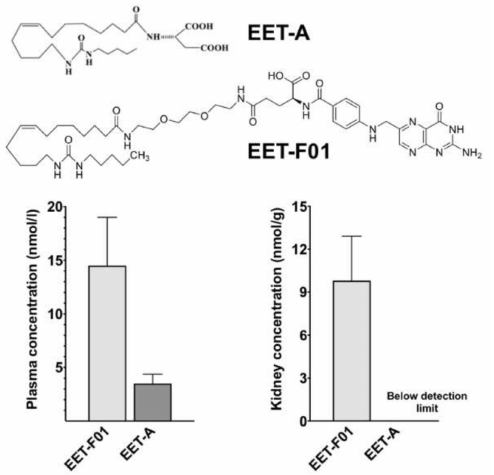
Figure 1. Comparison of plasma and kidney EET-F01 and EET-A following i.v. administration for 6 h. Top panel: Chemical structures for EET-A and EET-F01. Left panel: Plasma concentration of EET-F01 and EET-A. Right panel: Kidney levels of EET-F01 and EET-A. Data expressed as mean ± SEM, n =